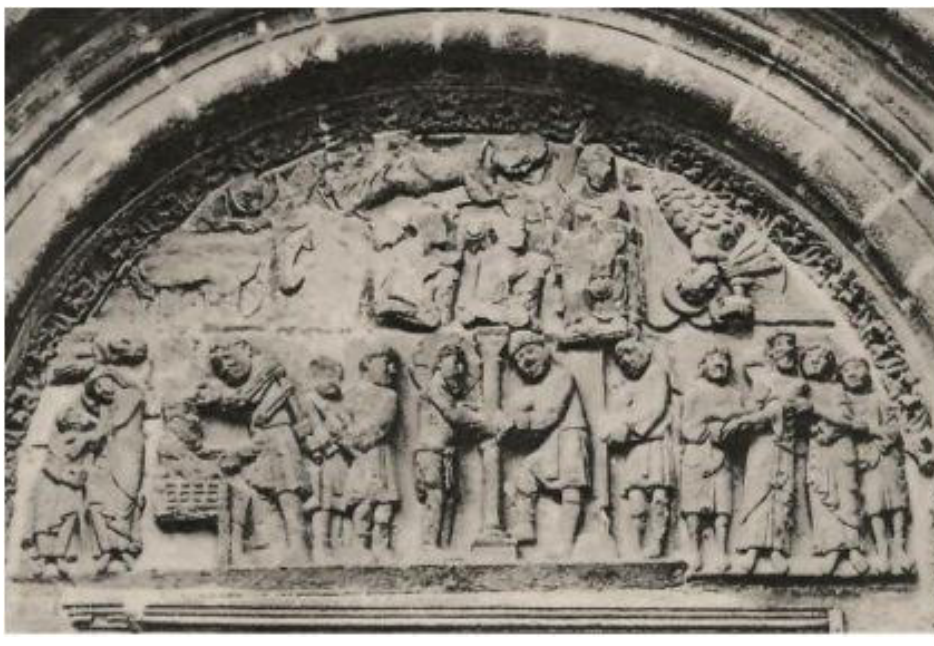
Figure 6 J. Roig, Puerta de las Platerías. Eastern tympanum. Adoration of the Magi; Doubting Thomas, Crowning with Thorns, Flagellation, Betrayal , from Arthur Kingsley Porter, Romanesque Sculpture of the Pilgrimage Roads , vol. 6, Castile, Asturias, Galicia (Boston: Marshall Jones Company, 1923), plate 680 (photo: author).